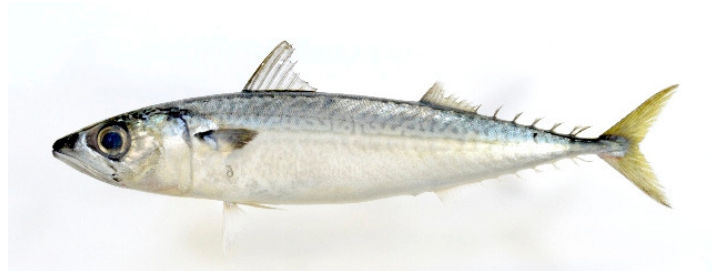
Figure 14. An incorrectly classified